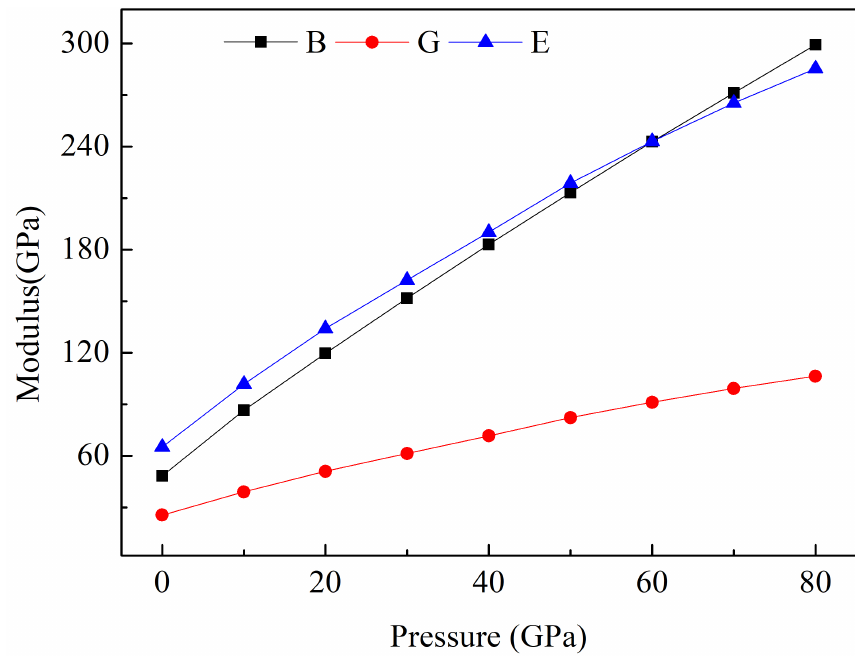
Figure 5. Plot of the variation in the bulk modulus B , Young’s modulus E , and shear modulus G , as a function of the applied pressure for β -Mg 17 Al 12